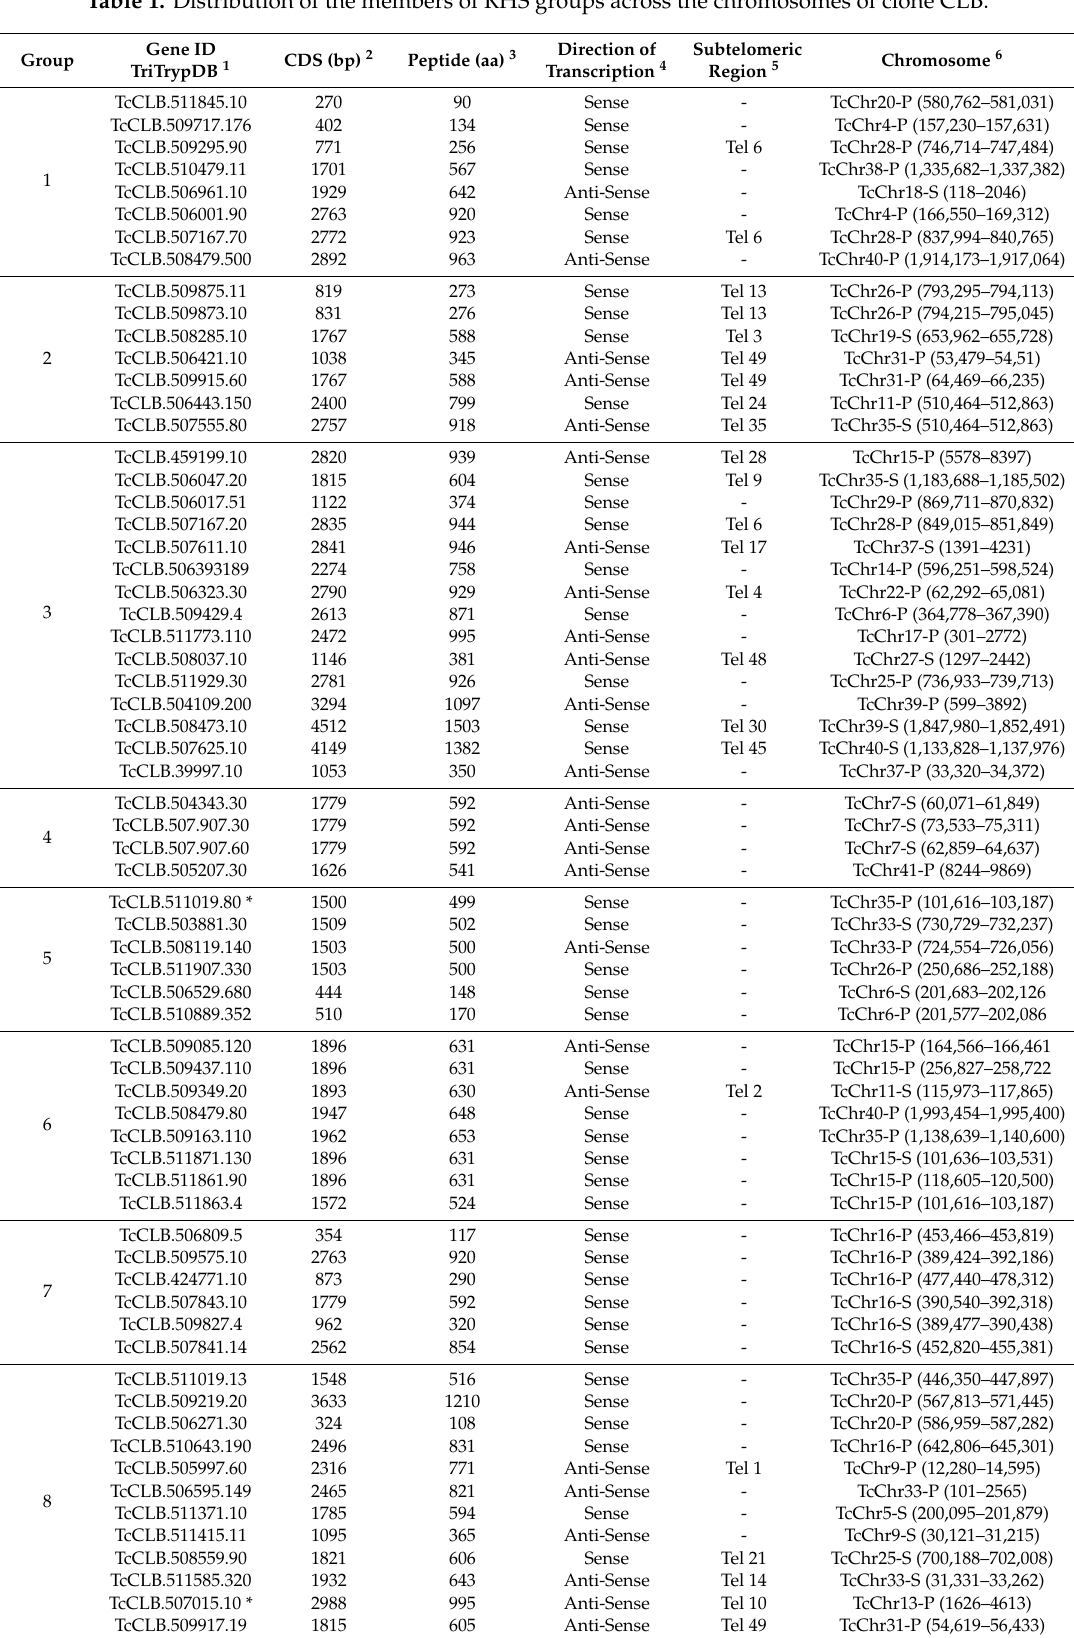
Table 1. Distribution of the members of RHS groups across the chromosomes of clone CLB.